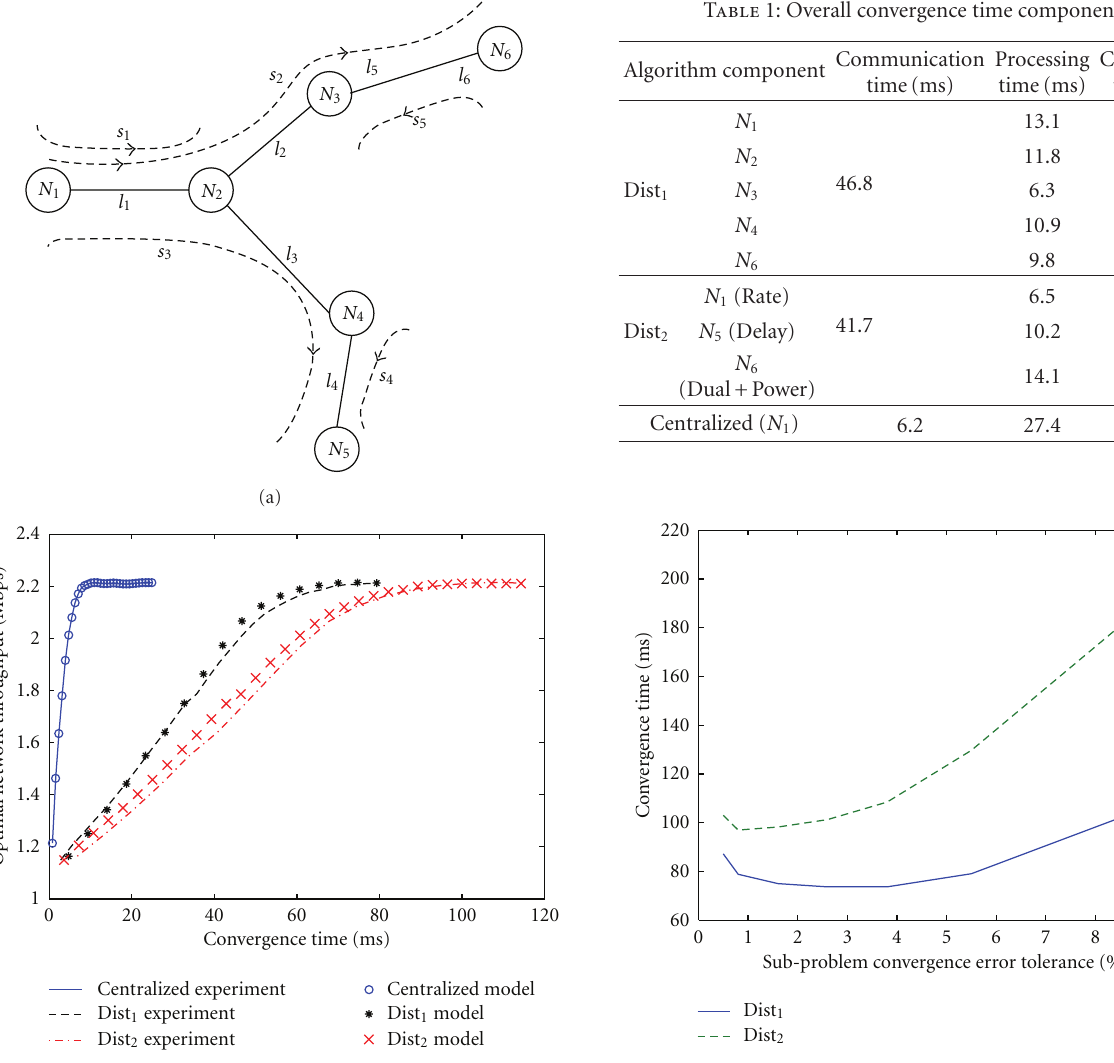
Figure 2: Convergence time as a function of percentage tolerance for the termination of iterative subproblem